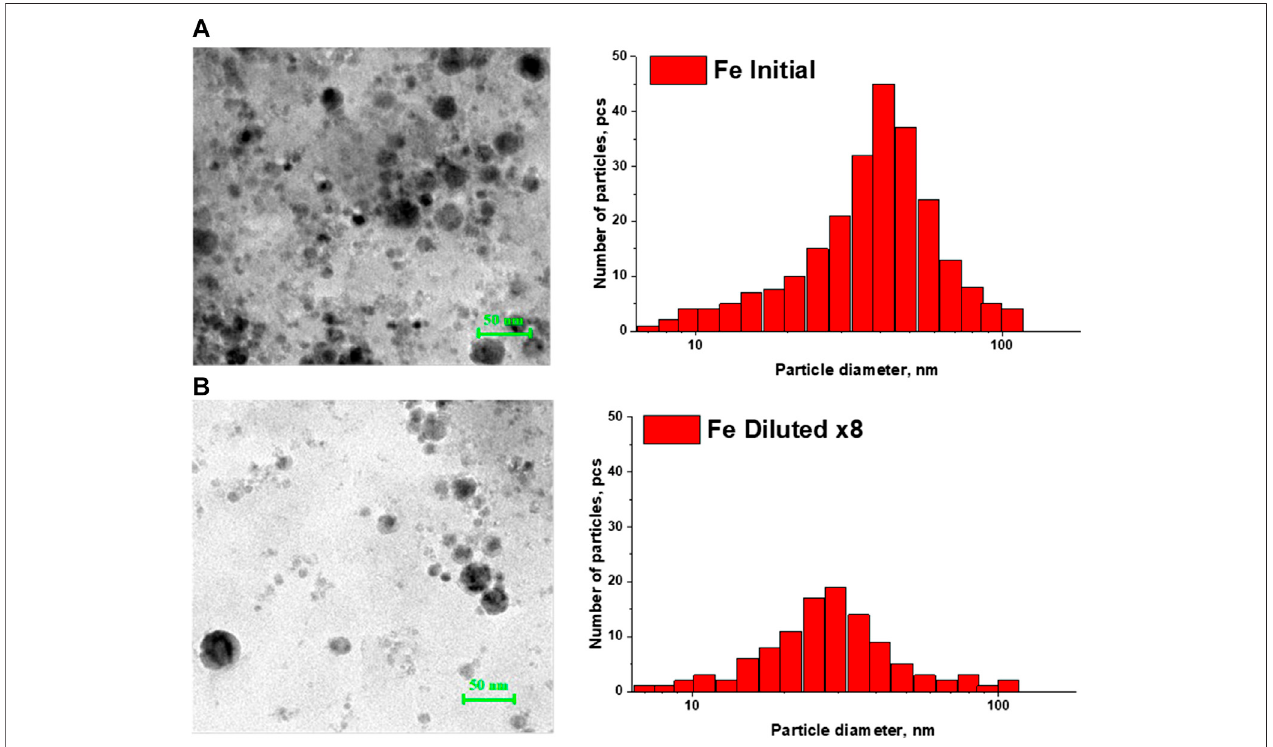
FIGURE 1 | TEM - images of iron nanoparticles and their calculated nanoparticle size distributions in: (A) initial colloid; (B) colloid diluted 8 times.